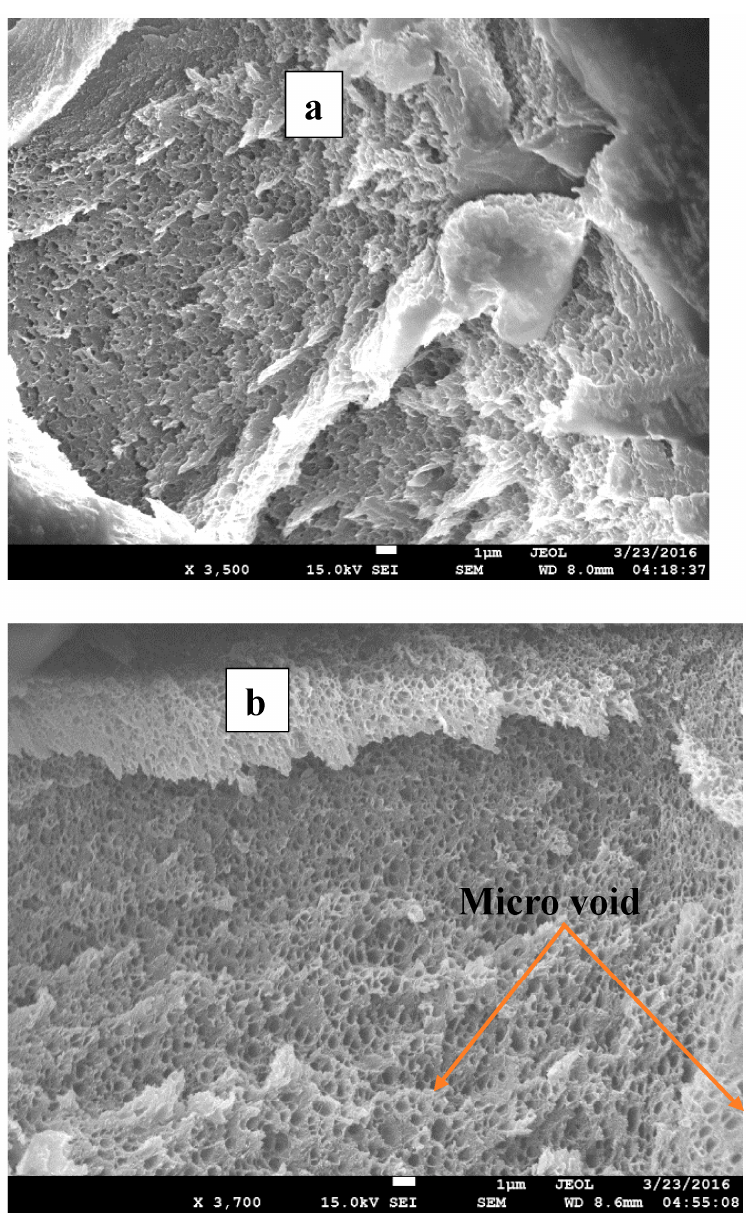
Figure 5. SEM image of a cross section of ( a ) neat CA fiber ( b ) CA-MWCNT 0.5 wt. % fiber.